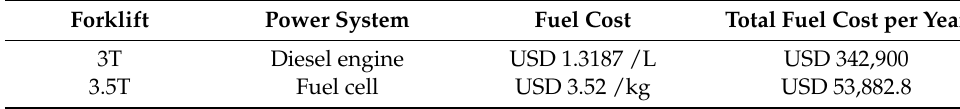
Table 2. The fuel cost of 20 forklifts with different power